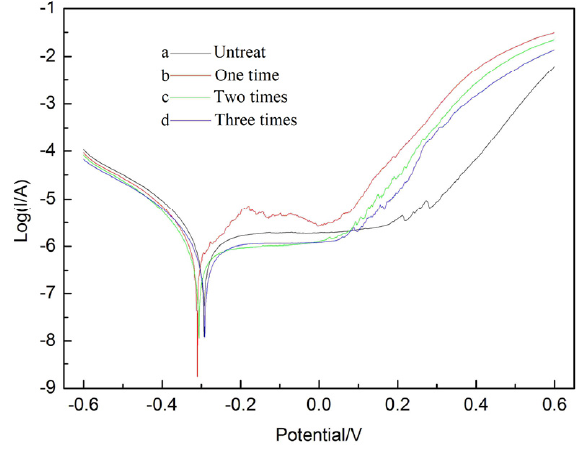
Figure 11. Polarization curves of the welded 316L stainless steel samples treated with different numbers of laser shock treatment.